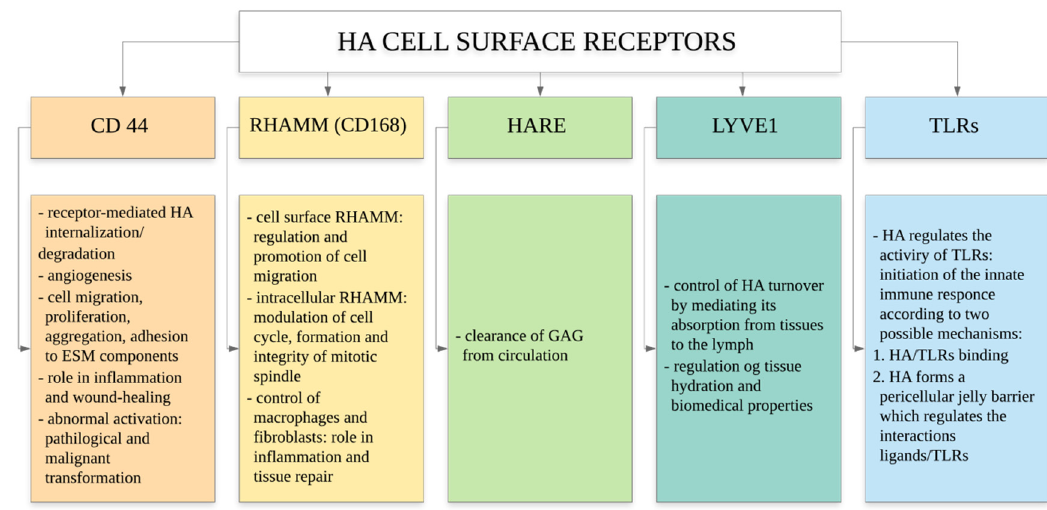
Figure 1. Hyaluronic acid cell surface receptors and their functions [5].